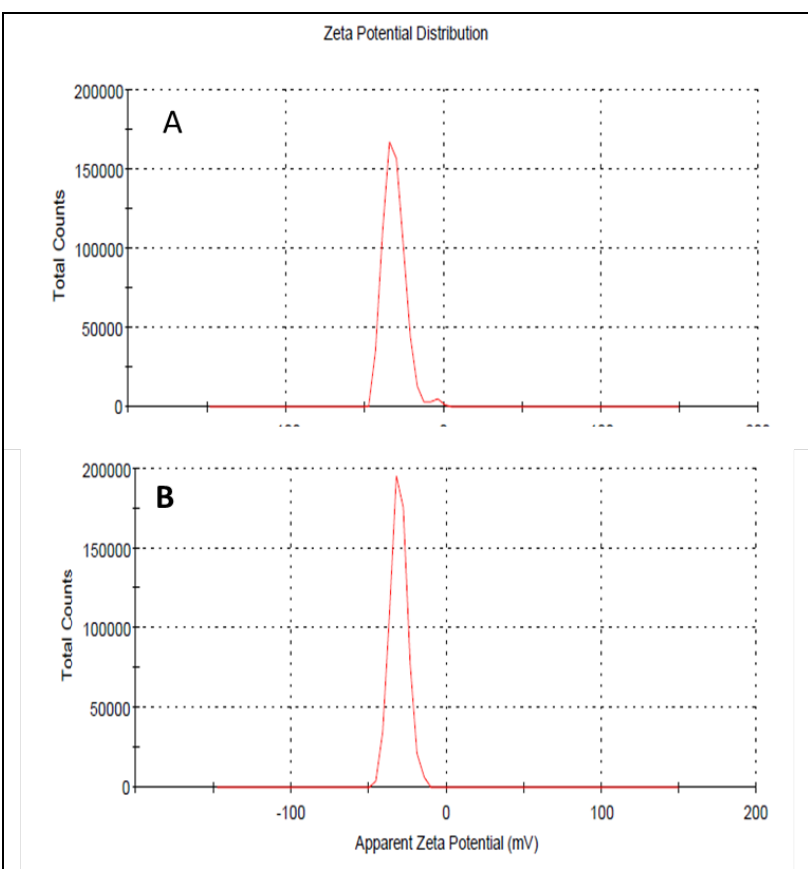
Figure 3. ( A ) Zeta potential distribution of ELE 1 and ( B ) ELE 2 formulations .